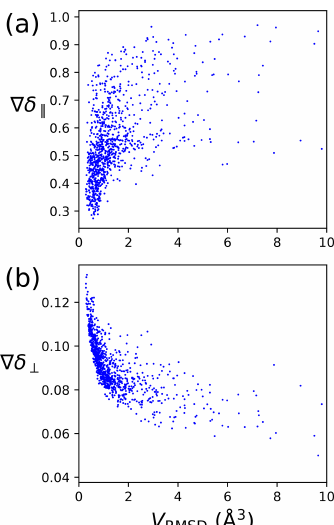
Figure 4. PCS orthogonality metrics versus localisation volumes determined by PCS RMSD. The calculations were performed for the model of four tags at a single site, with the SoI located 20Å from the paramagnetic centre. Each data point refers to a different set of relative (cid:49)χ tensor orientations. (a) Parallel metric. (b) Per- pendicular metric.